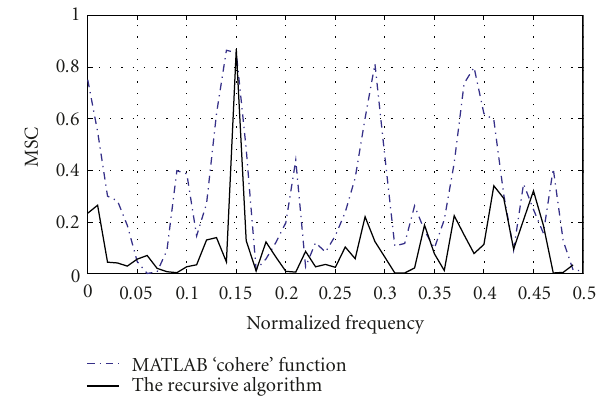
Figure 6: Estimation of the magnitude squared coherence function using both the Welch and the proposed approaches. Conditions of simulations: L = 50, K = 100, N = 256, and λ = 1 − 1 / (5 L